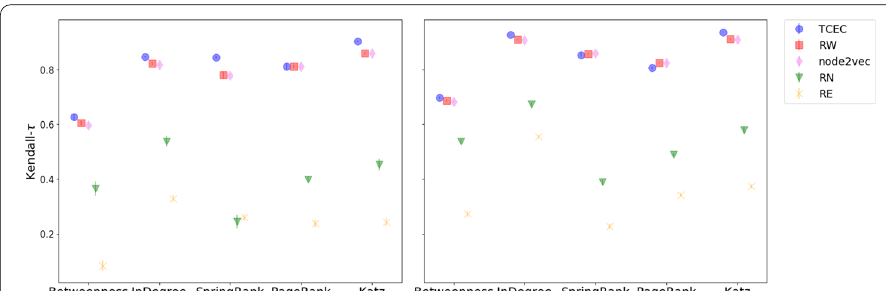
Fig. 9 Additional results for the approximation of different centrality measures on the Epinions dataset. Here the sample size varies from 5% (left) to 20% (right). Scatterplots represent average results over 10 runs on the three datasets, with standard deviation indicated by vertical lines